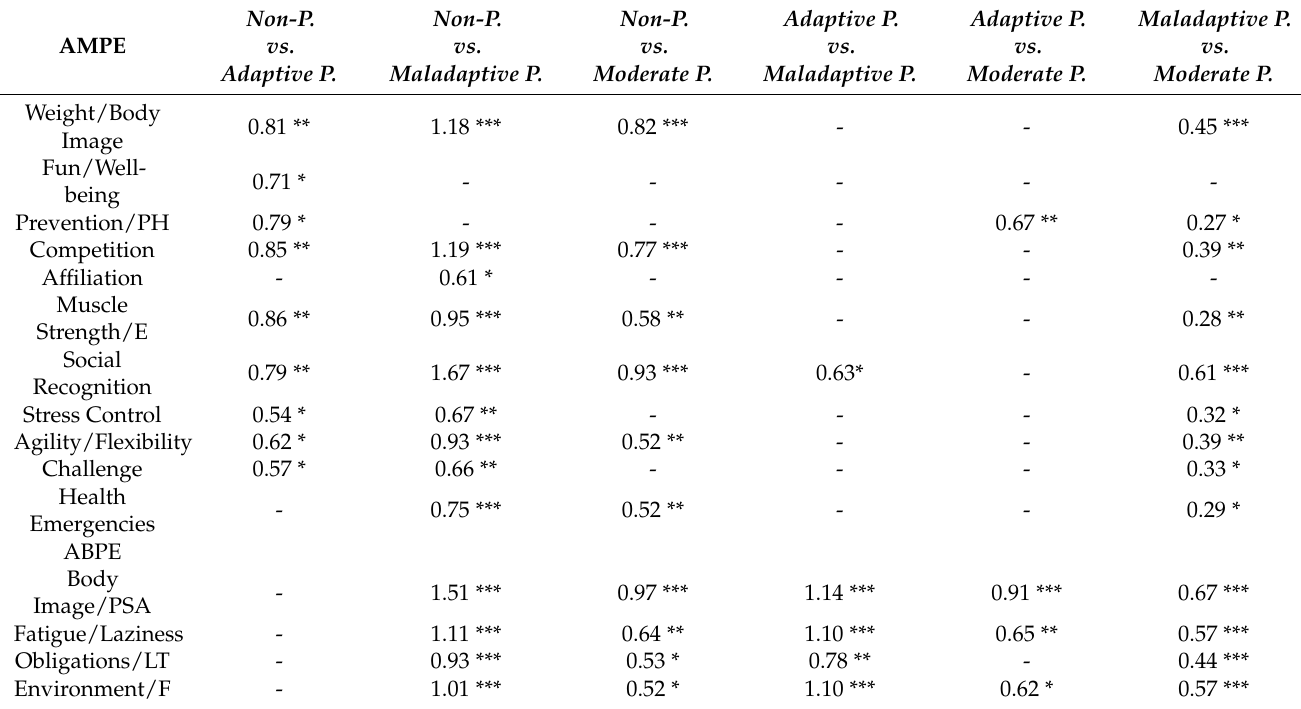
Table 3. Cohen’s d indexes for post hoc contrasts between the mean scores obtained by the four profiles on participation motives and barriers to